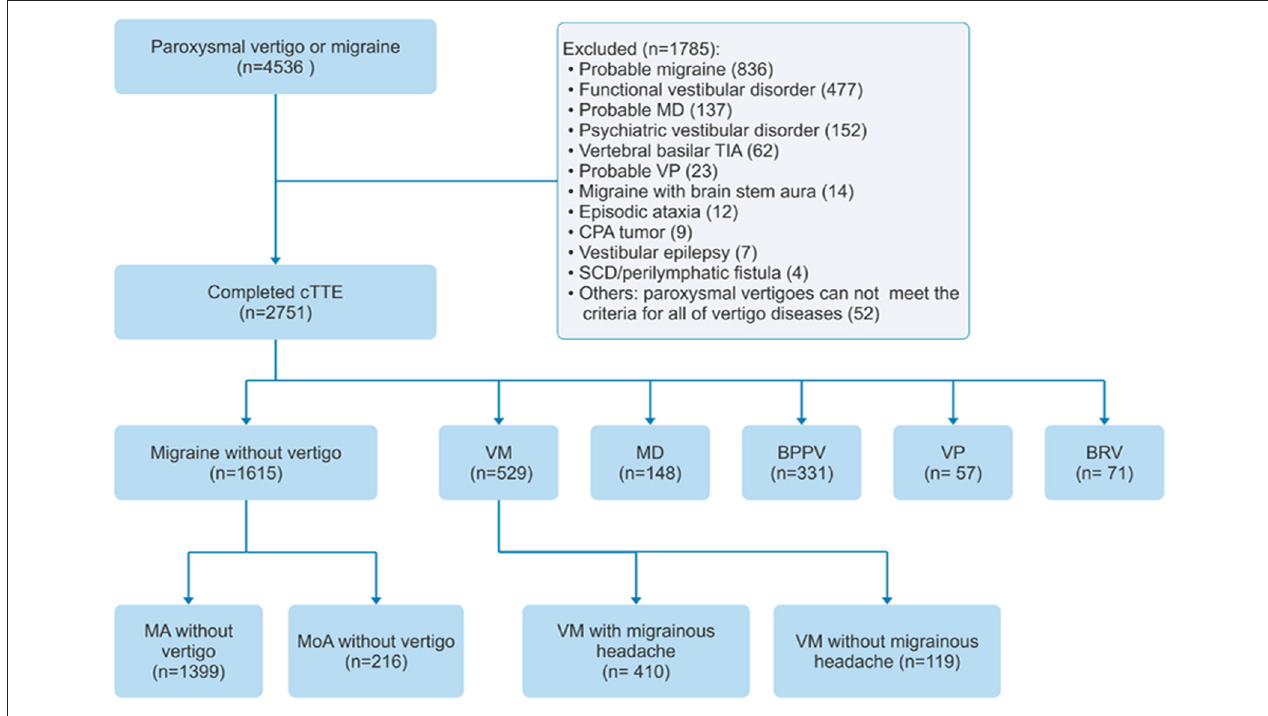
FIGURE 1 | Flowchart of the inclusion and exclusion of